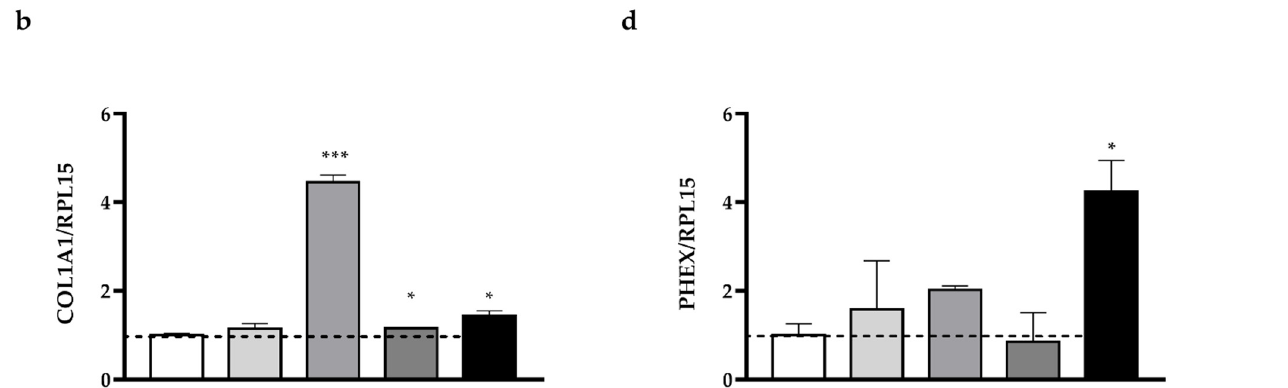
Figure 6. Gene expression of HOB-01-C1 cells at a day 12 after seeding (T12) and treated with different dilutions of PRP (1–25%). ( a ) RUNX2; ( b ) COL1A1; ( c ) OCN; ( d ) PHEX. Each gene was normalized for Ribosomal Protein 15 (RPL15). Data are reported as fold of expression (Fold change) vs. Negative Control and represented as mean ± SD of three independent experiments performed on sample 4. Statistical analysis was performed by one-way Anova. (* p < 0.05; ** p < 0.01; *** p < 0.001).